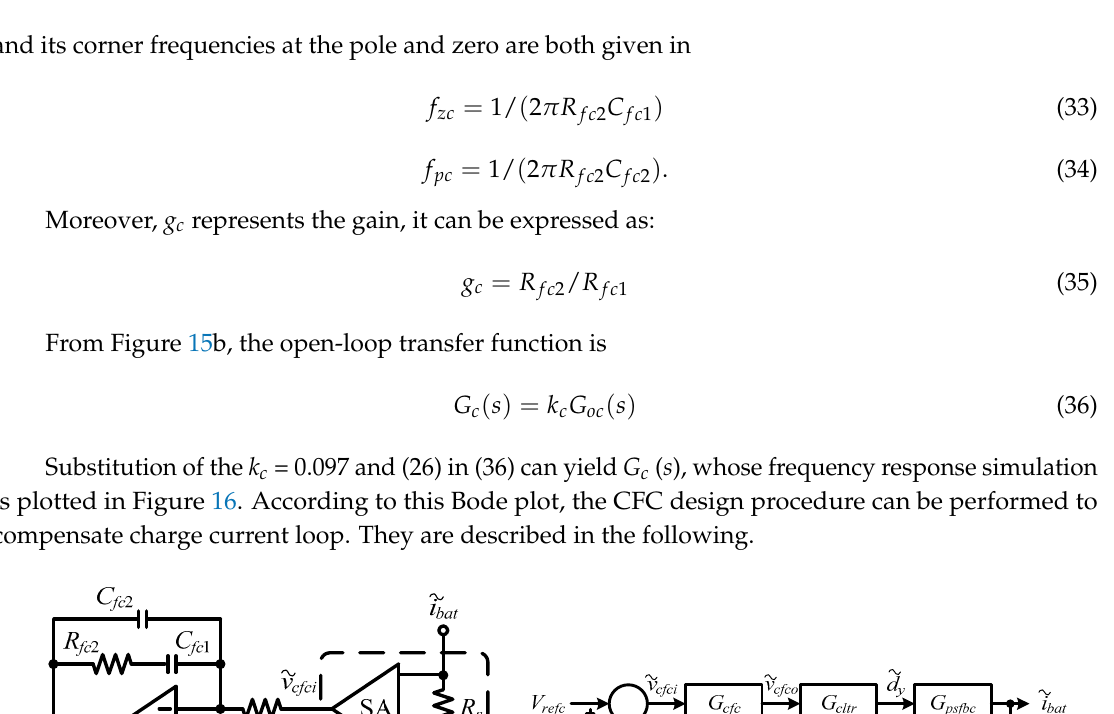
Figure 15. Charge current loop. ( a ) SA and current feedback controller (CFC) circuit. ( b ) Control block diagram of closed-loop operation.